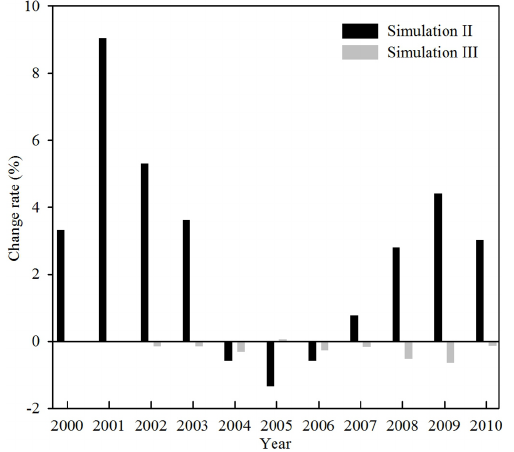
Fig. 15. Changes in national total ET output from Simulations II and III relative to that simulated in Simulation I.